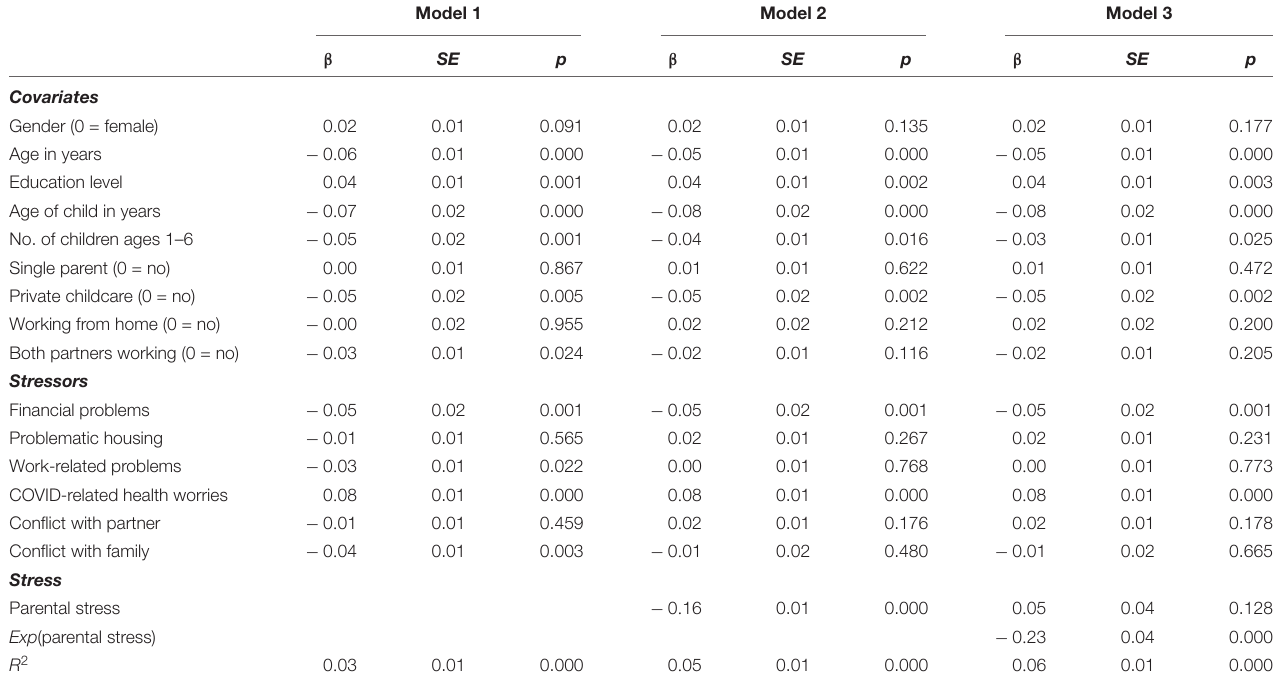
TABLE 3 | Regression results for stressors and perceived stress predicting changes in